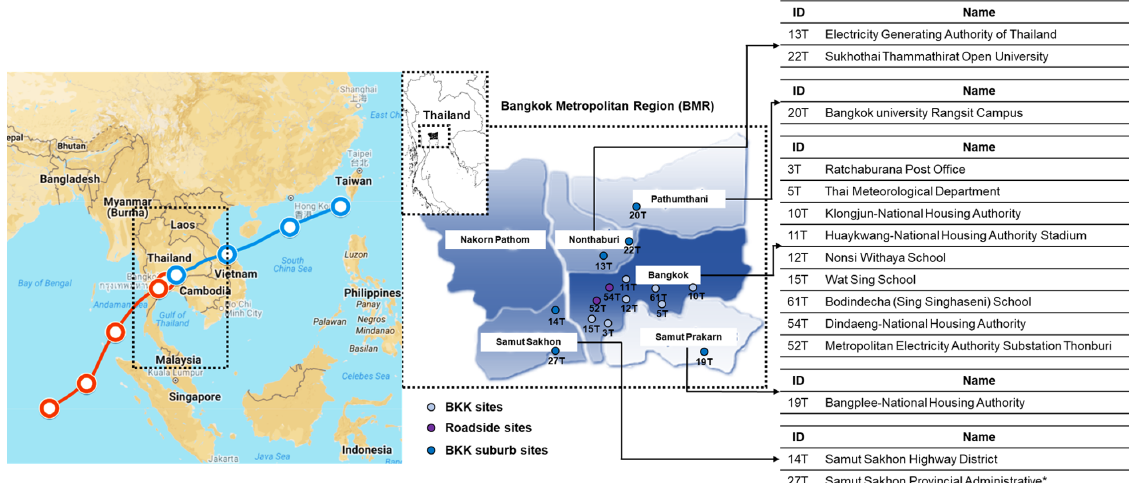
Figure 1. Map of BMR, the location of monitoring stations and two major monsoons winds (from NOAA HYSPLIT back trajectory model). Three monitoring station types (BKK sites, roadside sites and BKK suburb sites) are shown as light blue dots, purple dots and blue dots, respectively. (Note: * the station has been closed since 1 October